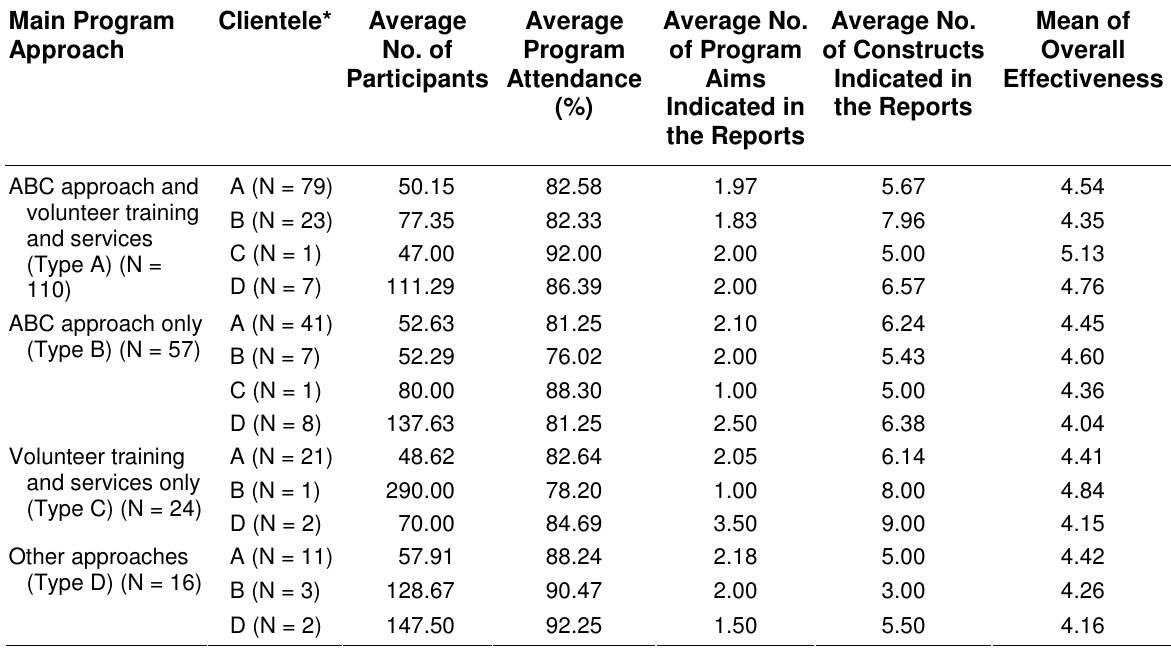
Summary of Program Characteristics and